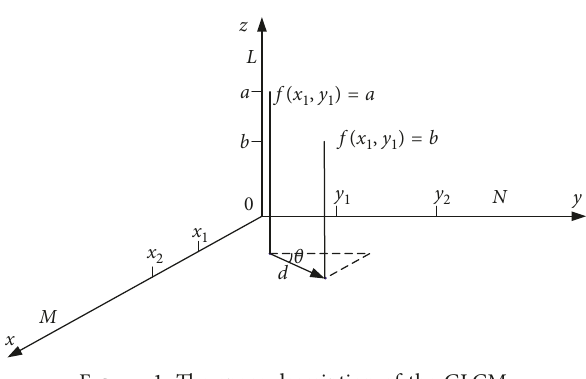
Figure 1: The space description of the